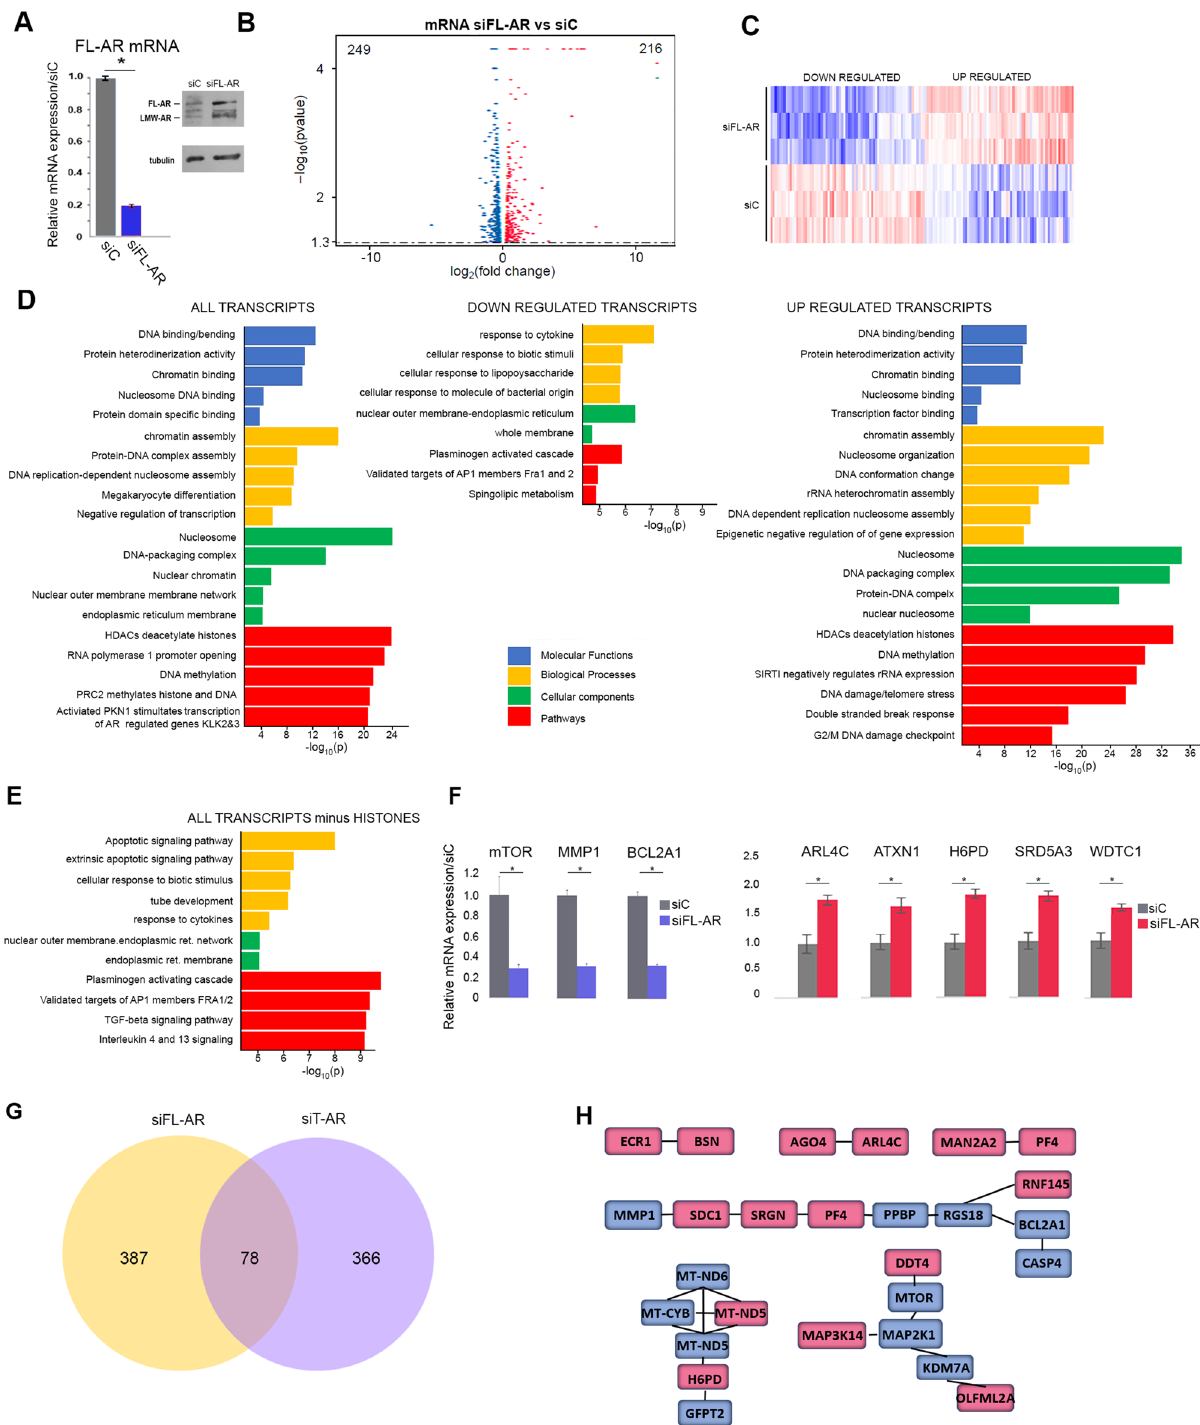
Figure 3. Transcripts regulated by FL-AR. ( A ) qRT-PCR (left) and immunoblot analysis (right) verified a robust depletion of FL-AR mRNA and protein, following a 3-day treatment with FL-AR targeting siRNA. ( B ) Volcano plot of transcripts activated (red) and repressed (blue) on FL-AR depletion. ( C ) Heatmap representation of transcript alteration on FL-AR depletion. ( D ) Gene enrichment analysis shows that histones are highly upregulated on FL-AR depletion. Molecular function (blue), biological processes (yellow) cellular components (green) and pathways (red). ( E ) Re-analysis of transcripts after removing histones identifies additional molecular functions, biological process, cellular components, and pathways altered on FL-AR depletion. ( F ) qRT-PCR verified alterations of selected transcripts. ( G ) Venn diagram of differentially and commonly regulated transcripts on depletion of all AR isoforms (blue) or FL-AR only (yellow). ( H ) Interactions of commonly regulated targets. Downregulated transcripts- blue, upregulated transcripts- red. qRT-PCR studies were in triplicate. * P -value < 0.05. Immunoblots were cropped prior to incubation with specific